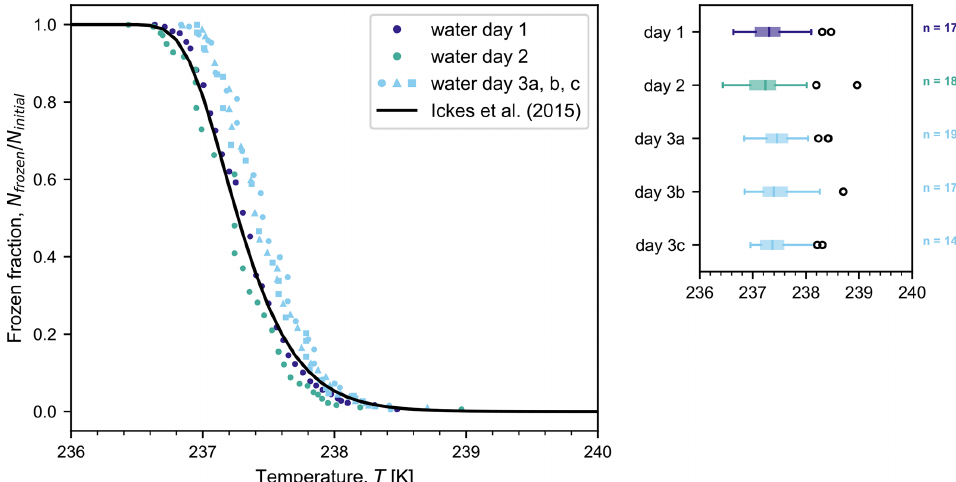
Figure 3. Frozen fraction of pure water (Sigma-Aldrich) droplets (with diameters as indicated in Table 1) as a function of temperature for different droplet populations (with n number of droplets) cooled at a rate of 1Kmin − 1 on three separate days. The droplet population on day 3 was subjected to three freeze–thaw cycles (a, b, c). Also shown is the frozen fraction curve for the homogeneous freezing of water using the parameterization from Ickes et al. (2015) for droplets with a diameter of 75µm. Box plots on the right-hand side summarize the experimental results. The centre line of each box plot indicates the median freezing temperature, the box spans the interquartile range (between the 25th and 75th percentiles), the whiskers extend to the maximum and minimum temperatures, and outliers are shown by open circles. The temperature accuracy of our measurements is estimated to be ± 0 .